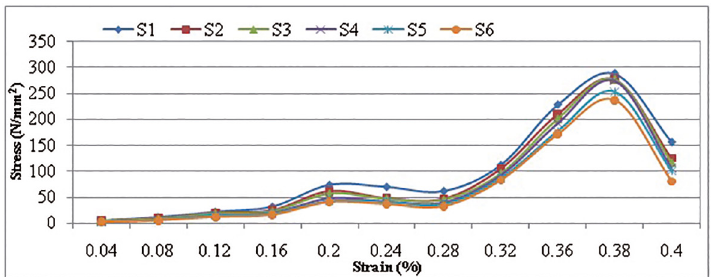
Figure 8: Stress-strain curves for the composite samples subjected to tensile loading